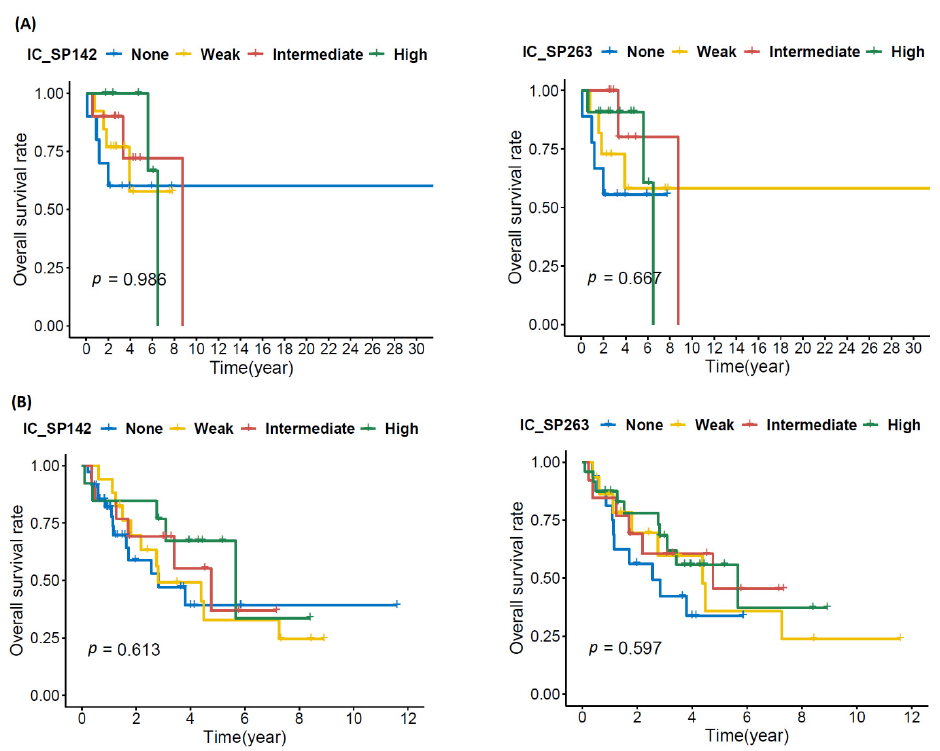
Biomolecules 2022 , 12 , x Figure A4. Kaplan–Meier curves depicting overall survival (OS) based on PD-L1 immunoreactivity in immune cells for ( A ) liposarcoma and ( B ) undifferentiated pleomorphic sarcoma.